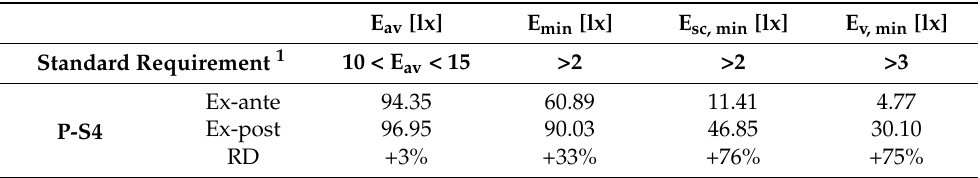
Table 7. Lighting performances of the ex-ante and ex-post installations for the pedestrian square area (Cassero square).